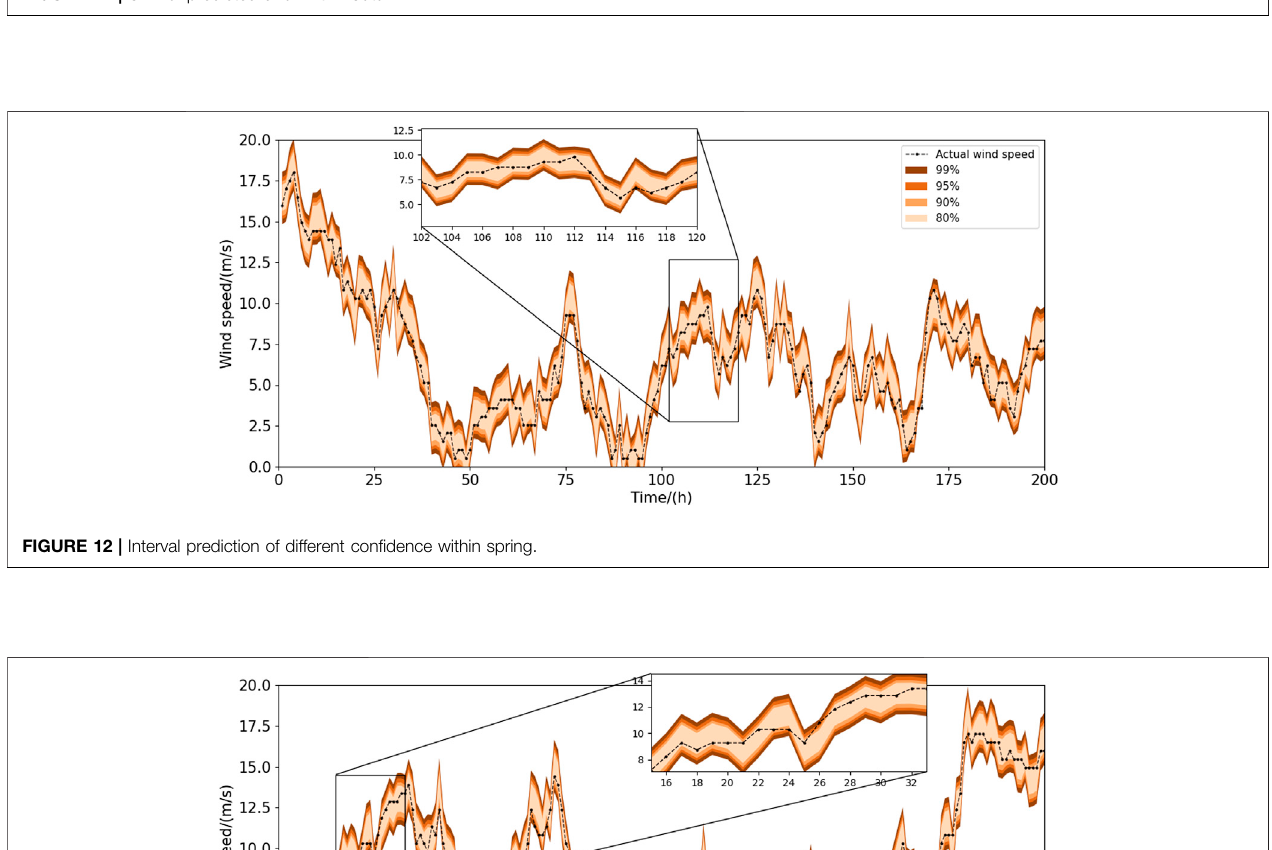
FIGURE 11 | CDF of predicted error within autumn.